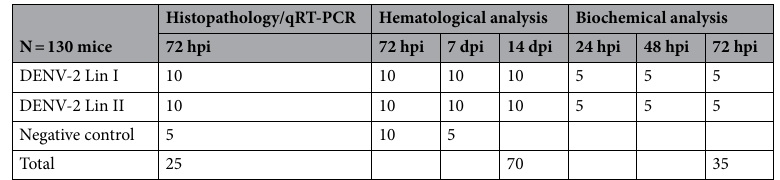
Table 3. Number of mice used for histopathological, hematological and biochemical analysis and viral RNA quantification. hpi: hours post infection, dpi: days post infection, Lin: Lineage.